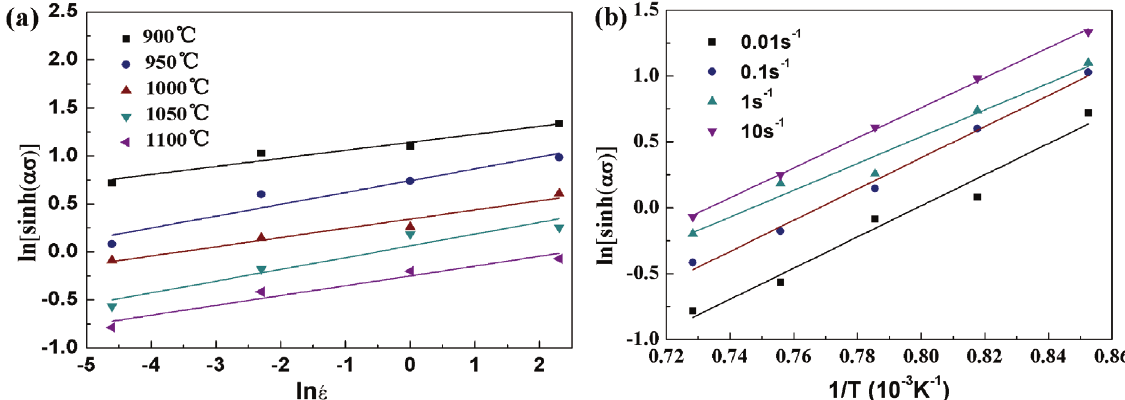
Fig. 4: Evaluating the value of: (a) Q by fitting ln[sinh( ασ )] − ln έ plot; (b) ln A by fitting ln[sinh( ασ )] − 1/T